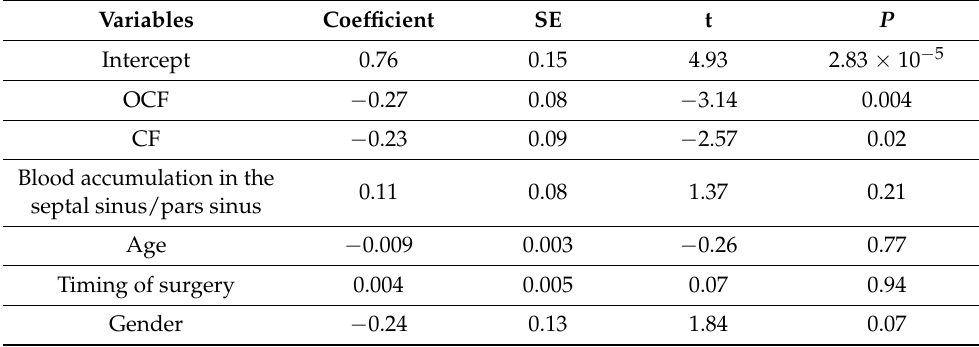
Table 4. Multiple linear regression analysis of IDVA in patients with